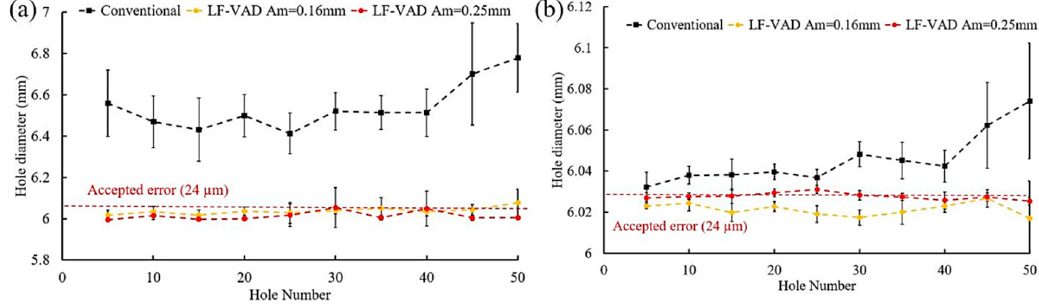
Figure 21. The effect of machining technique and wear progress on the hole accuracy at N = 37.68 m/min for ( a ) CFRP and ( b ) Ti6Al4V.